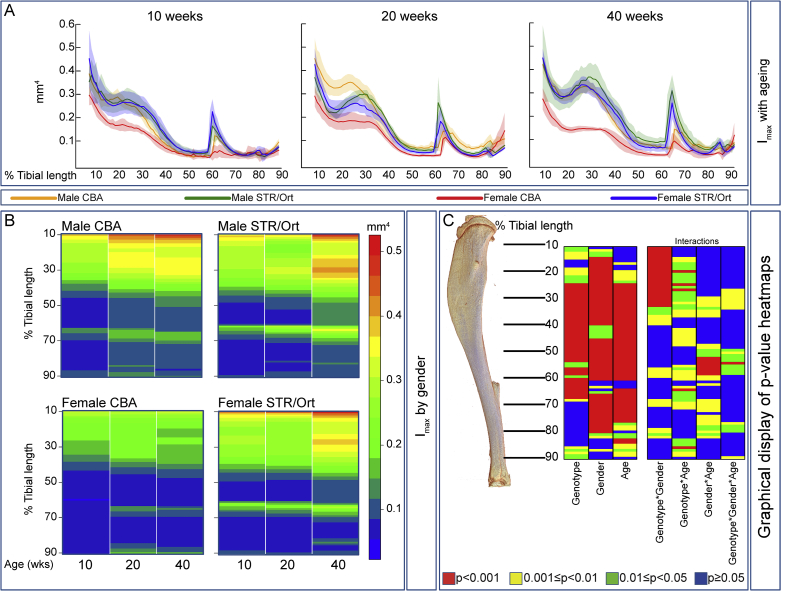
Analysis of Imaxalong the entire length of the tibia. (A) Mean Imax in male and female CBA (brown and red, respectively) and STR/Ort (green and blue, respectively) mice at 10, 20 and 40 weeks of age. (B) ‘Heat map’ representation of identical data-set (red-blue colour scale depicts mean Imax) for male and female CBA (left) and male and female STR/Ort (right) enabling ready comparison (at each percentile of length) between 10, 20 and 40 weeks of age. (C) Statistical significance of differences in Imax along the entire tibial shaft, represented as a heat map. The contributions of genotype (CBA vs STR/Ort), gender, age (10, 20 and 40 weeks), and their interactions at locations from 10 to 90% of tibial length are illustrated. Red P < 0.001, yellow 0.001 ≤ P < 0.01, green 0.01 ≤ P < 0.05 and blue P ≥ 0.05. Line graphs represent means with 95% CI. Group sizes were n = 5 for male and female CBA and STR/Ort mice.